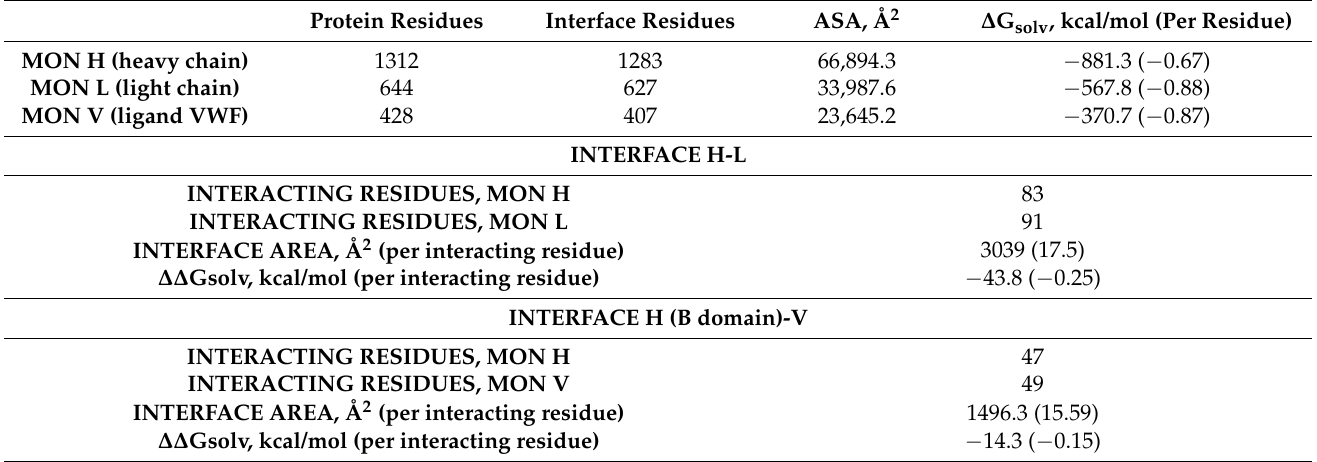
Table 4. PISA results for the VWF/FL-FVIII complex. Values within brackets refer to the value specific per residue. Accessible surface area (ASA) of interface (Å 2 ).